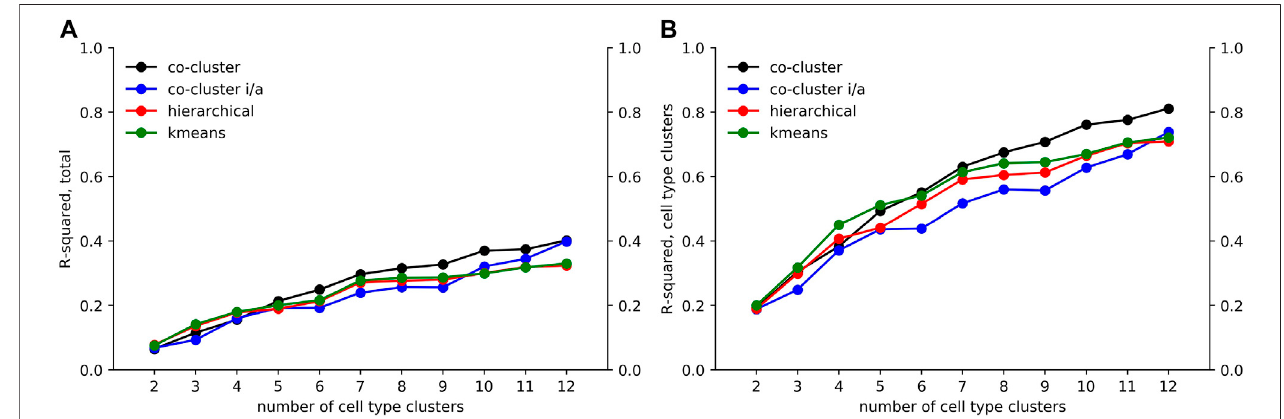
( k ) ( k ) and ~ M i / a as well as co-clustering in which columns were clustered using